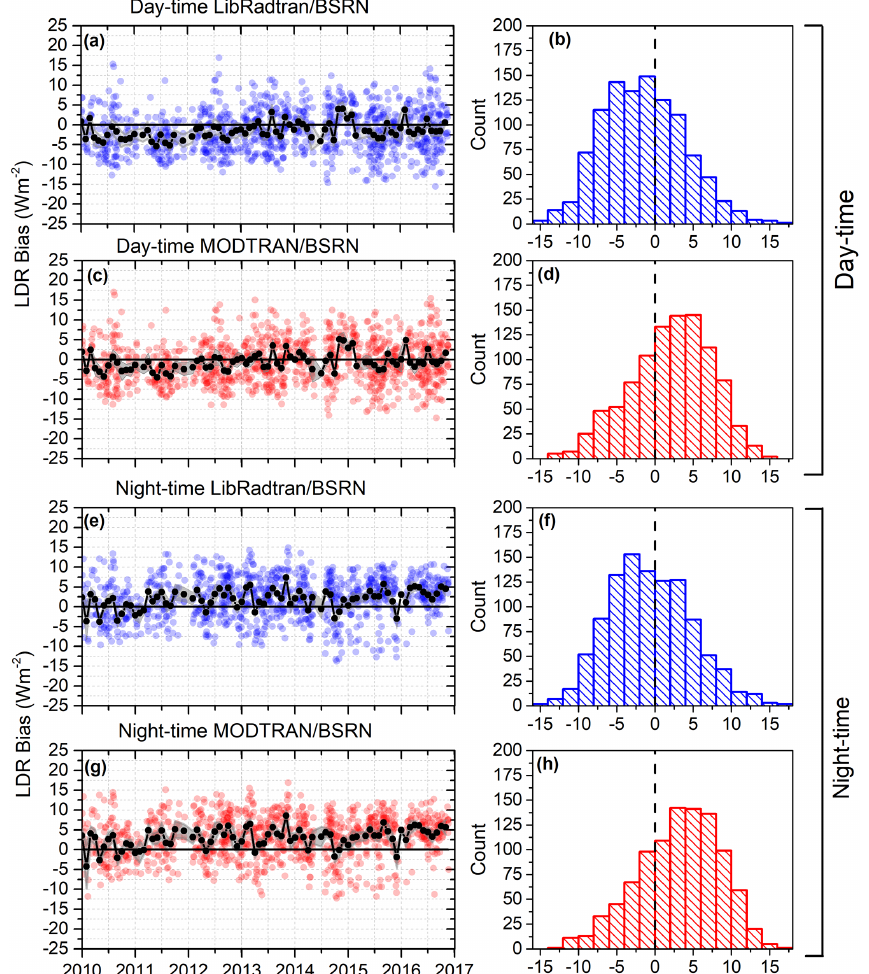
Figure 6. Time series and histogram of LDR bias (model–BSRN in Wm − 2 ) between 2010 and 2016 at IZO. The blue and red dots represent the instantaneous bias for libRadtran/BSRN and MODTRAN/BSRN, respectively. The black dots represent the monthly mean bias. The grey shadings show the range of ± 1SEM (standard error of the monthly mean